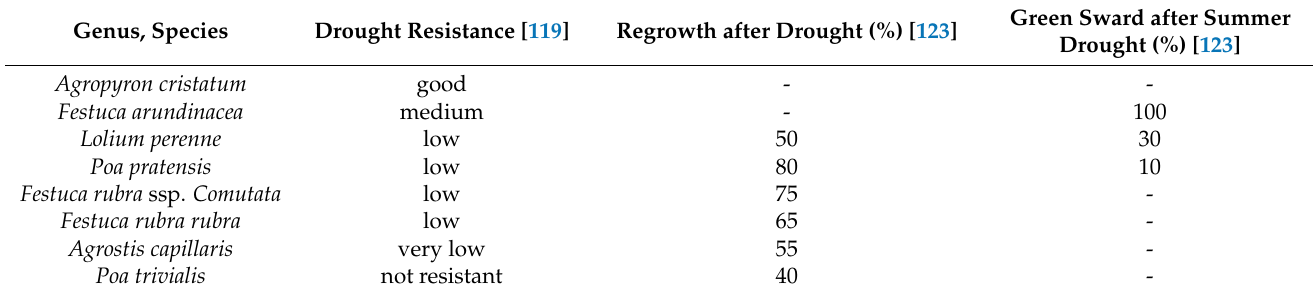
Table 4. Comparison of differently expressed drought resistance of some turf grass